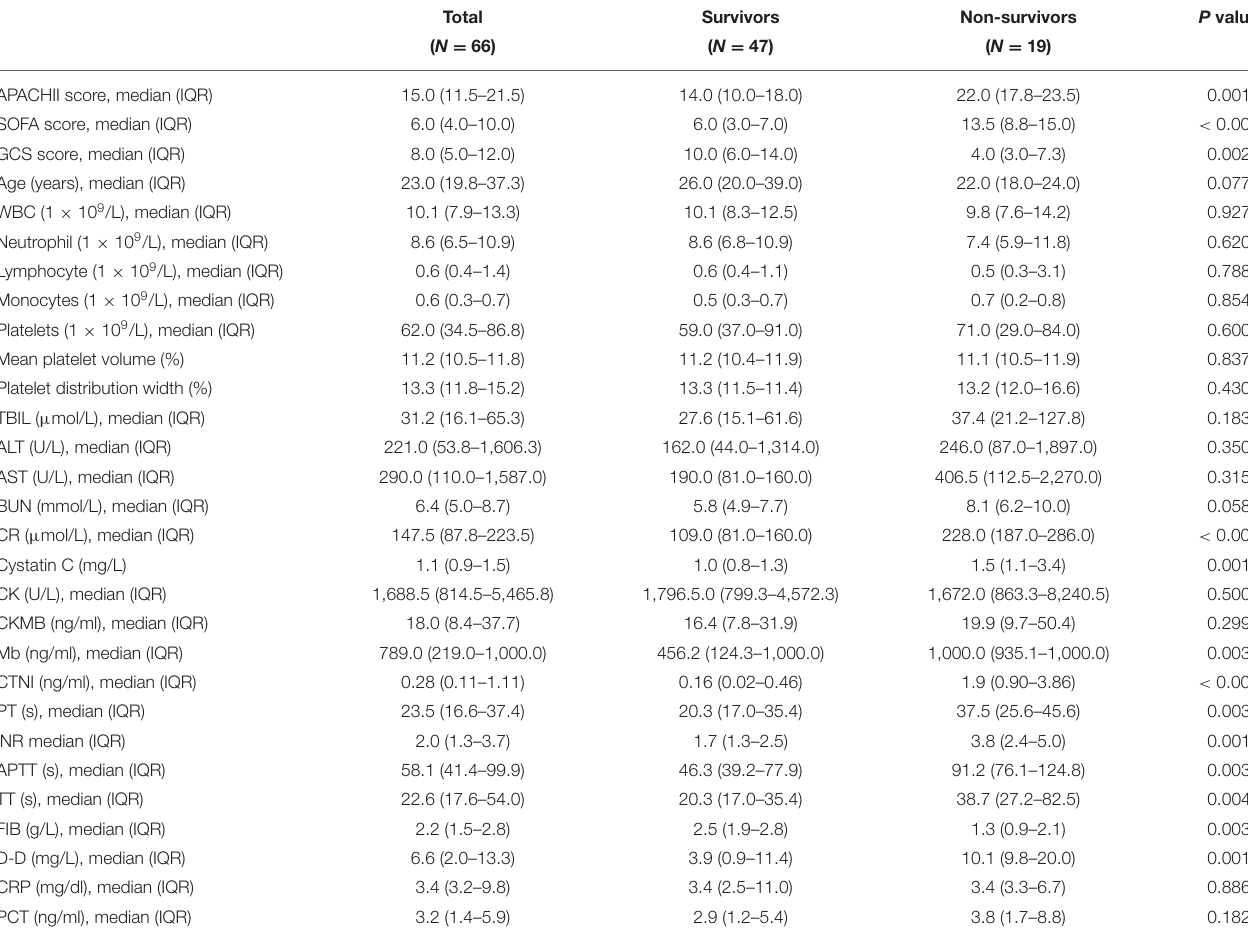
TABLE 3 | Baseline characteristics of survivors and non-survivors in patients with PLT-abnormal. Total Survivors Non-survivors P